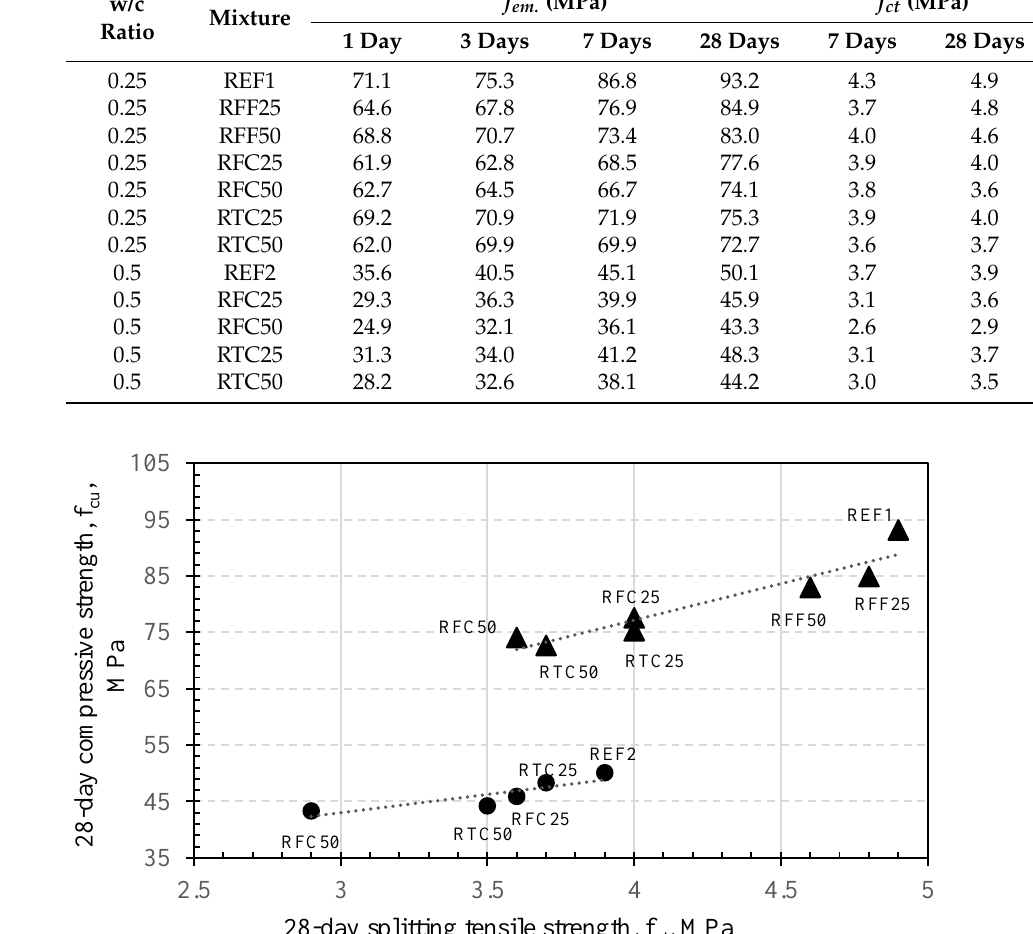
Figure 7. Relationship between f ct and f cu of concretes at 28 days ▲ = w/c ratio 0.25; ● = w/c ratio 0.5.